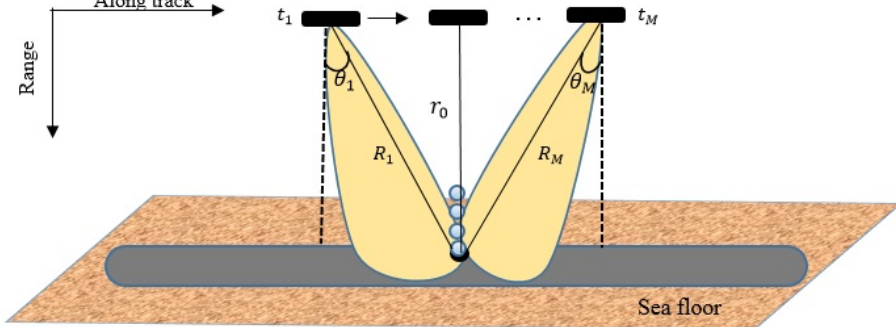
Figure 4. Geometry of data collection in the proposed method. SAS platform moves in the along- track direction with constant speed and by transmitting successive pulses in M positions with equal distances and receiving echoes in time series t (cid:2923) , which forms a synthetic aperture .